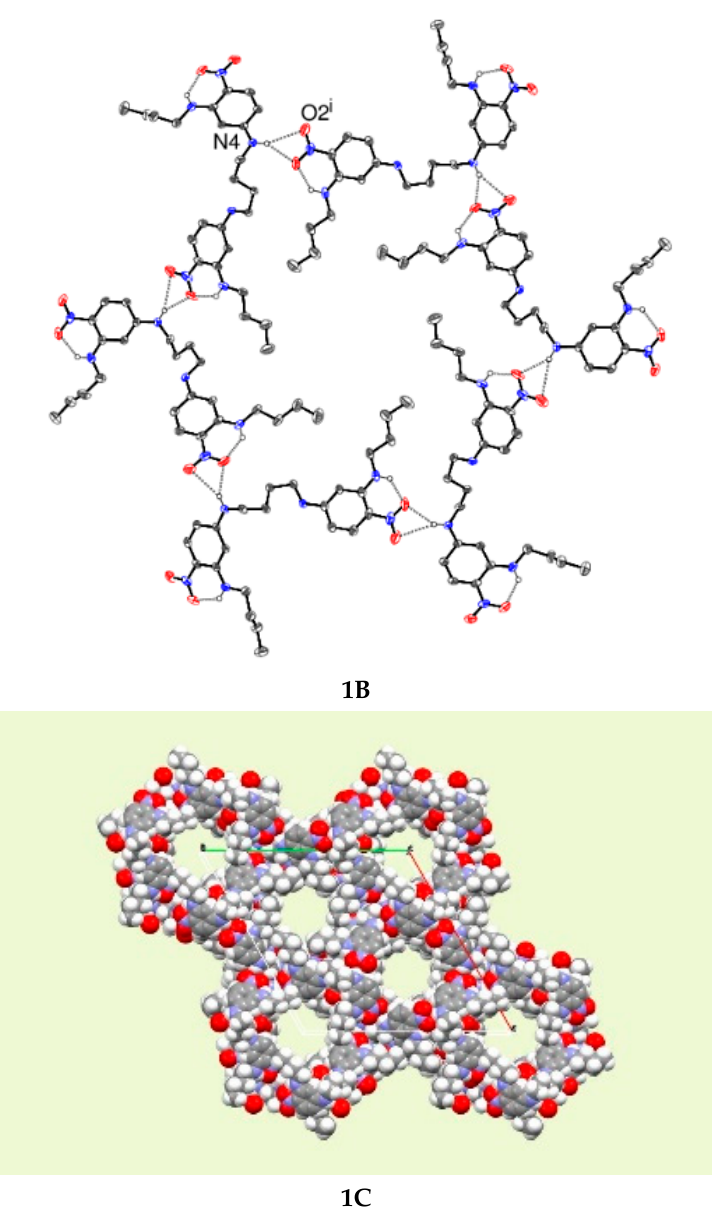
Figure 1. 1A Drawing of N 1 , N 1 ’-(butane-1,4-diyl)bis( N 3 -butyl-4-nitrobenzene-1,3-diamine); 1B A cross section of the crystal structure showing the packing of compound 1 leaving a hole or channel; 1C Packing diagram of compound 1 showing the unfilled 10 Å diameter pores.